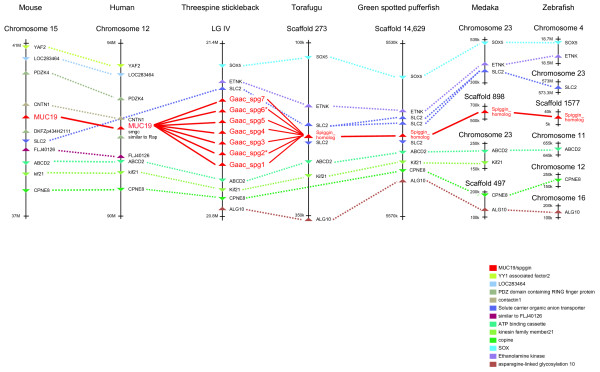
Diagrammatic representation of the chromosomal location of the spiggin multi-gene family, its homologs, and Muc19. Spiggin (threespine stickleback), spiggin homologs (torafugu, spotted green pufferfish, medaka, and zebrafish), and Muc19 (mouse and human) are indicated in red, and other genes are indicated in other colors. Orthologous genes are connected by dotted lines. Spiggin, its homologs, and Muc19 are connected by solid lines.